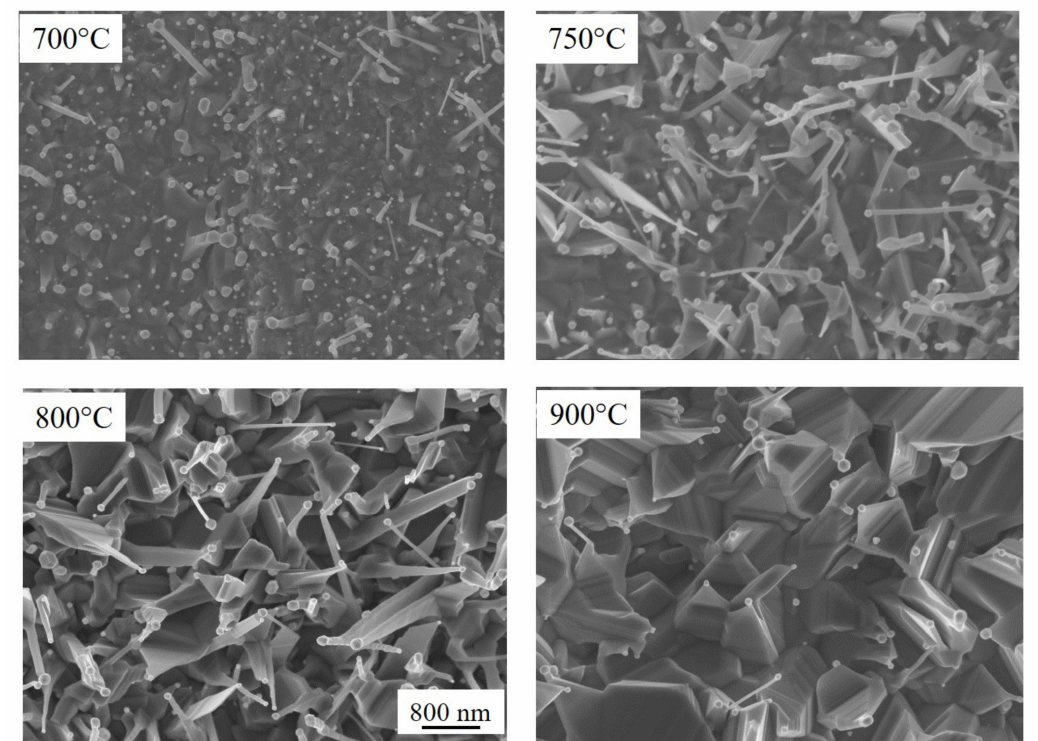
Figure 1. SEM images in plan-view of the TiO 2 NWs grown at different temperatures for a fixed annealing time of 4 h. Marker is the same for all images.